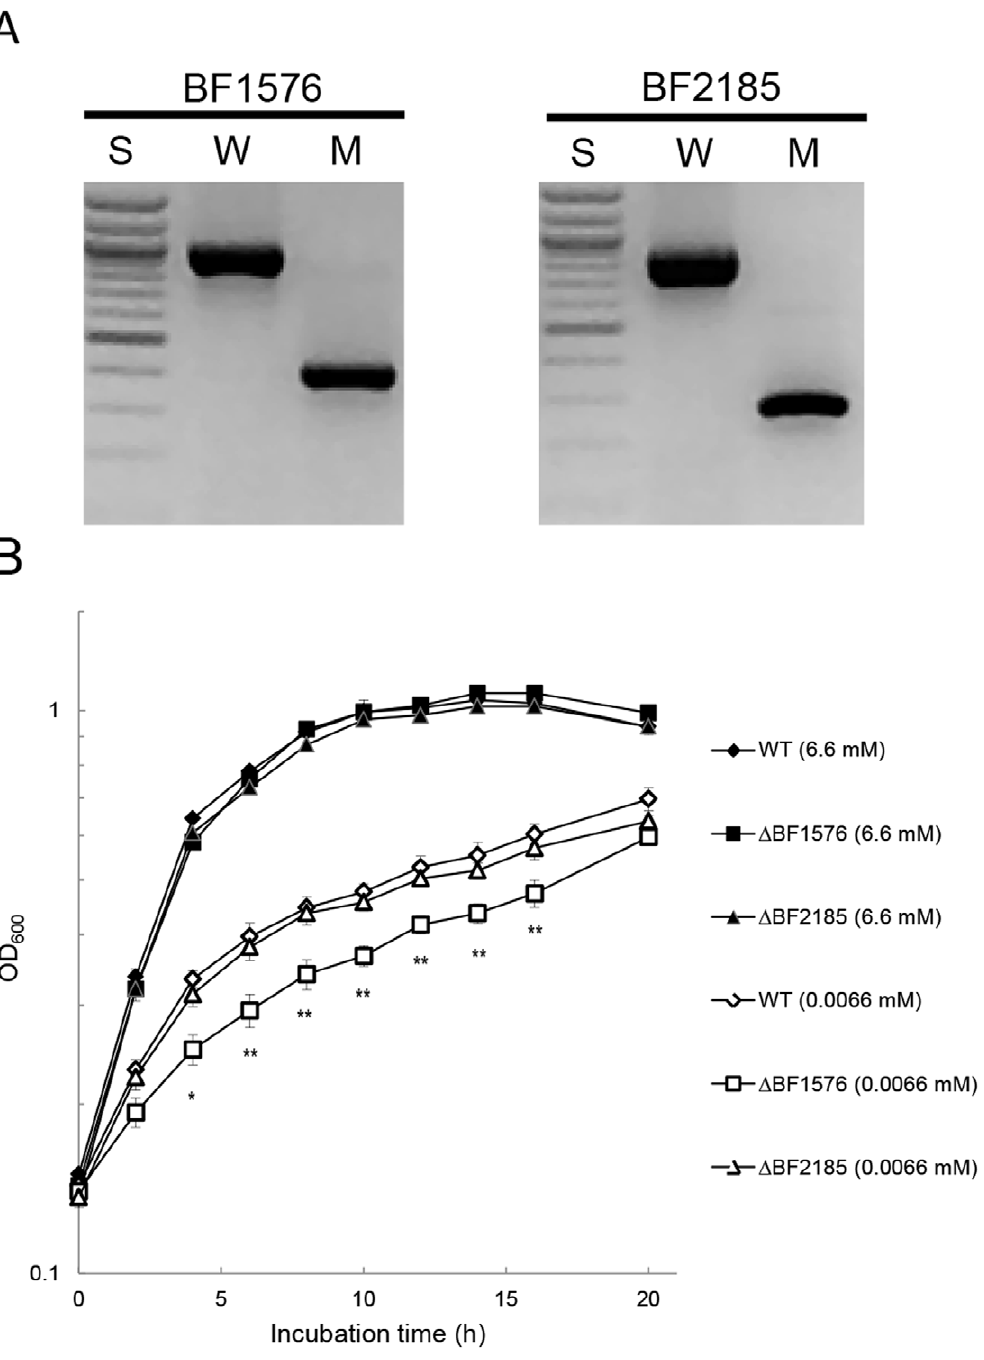
Figure 2. Effect of BF1576 deletion on the growth in Pi-limiting media. (A) Construction of D BF1576 and D BF2185 strains. Internal deletion of each gene was confirmed by PCR using a primer pair encompassing each deletion site. W, wild type B. fragilis ; M, mutant form of indicated gene; S, 100-bp ladder size markers. (B) Growth of wild type (WT), D BF1576 and D BF2185 strains under Pi-rich and Pi-limiting conditions. WT (diamonds), D BF1576 (squares), and D BF2185 (triangles) strains of B. fragilis were grown anaerobically in DMM supplemented with 6.6 mM (closed symbols) or 0.0066 mM (open symbols) of KH 2 PO 4 . Growth was measured at OD 600 . Data presented are the means 6 standard deviations of triplicate cultures. **Significantly different from wild type ( p , 0.01), *Significantly different from wild type ( p , 0.05). doi:10.1371/journal.pone.0053829.g002 as bait DNA. After incubation, the samples were subjected to polysaccharide biosynthesis loci B (PS B, BF1828-BF1848) and E (PS E, BF2566-BF2586), or internal fragment of BF3397 were electrophoresis on a 5% polyacrylamide gel and visualized using amplified by PCR. The amplicons were purified using a QIAquick the SYBR Green I Nucleic Acid Gel Stain Kit (Invitrogen). Gel Extraction Kit (Qiagen) after agarose gel separation and used